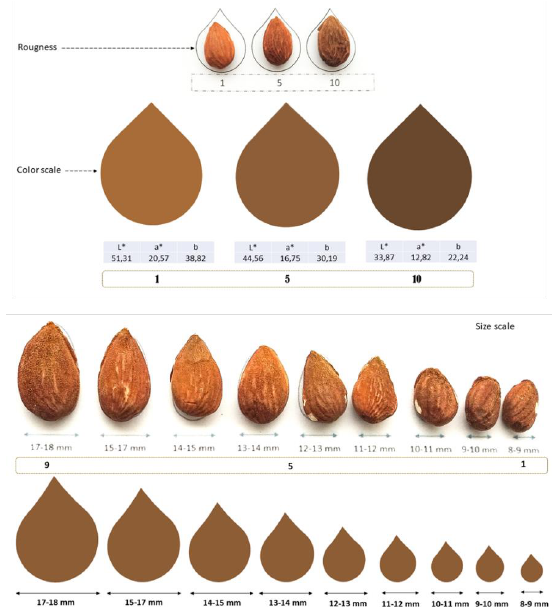
Figure 2. Scales reference used by trained panel to evaluate the almond appearance in this study.